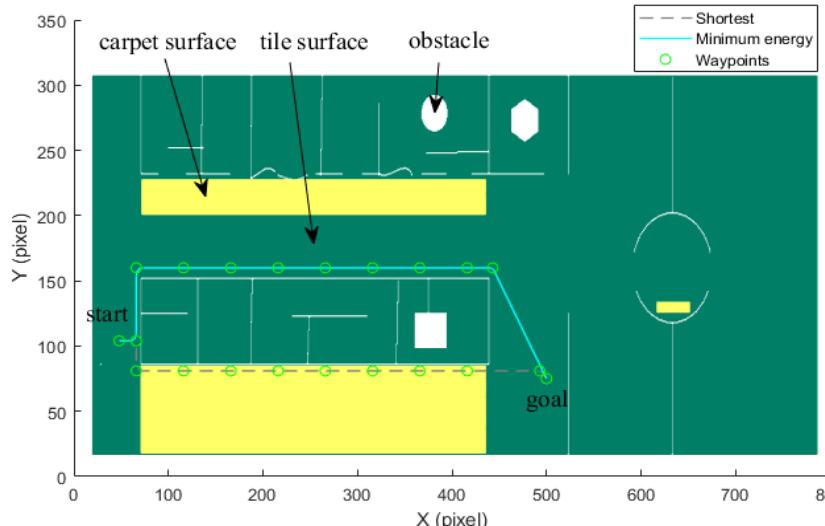
Figure 10. Optimal trajectory based on minimum energy in the long corridor region. Table 5. Simulation results in case (2).